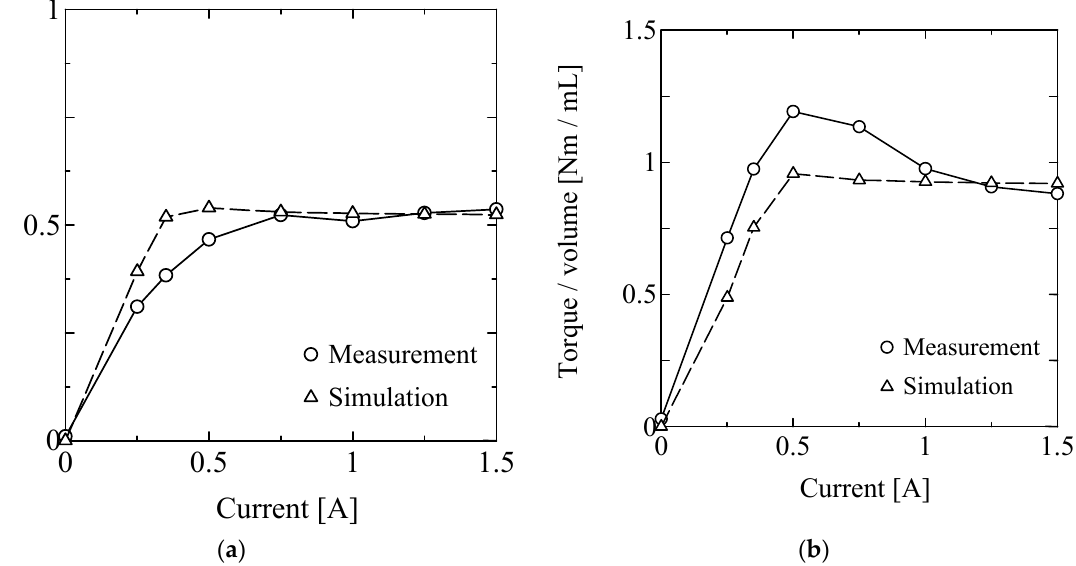
Figure 13. Torque estimation and measurement for the sample 1 (Micron MRF). ( a ) Parallel plate, ( b ) V-shaped plate.